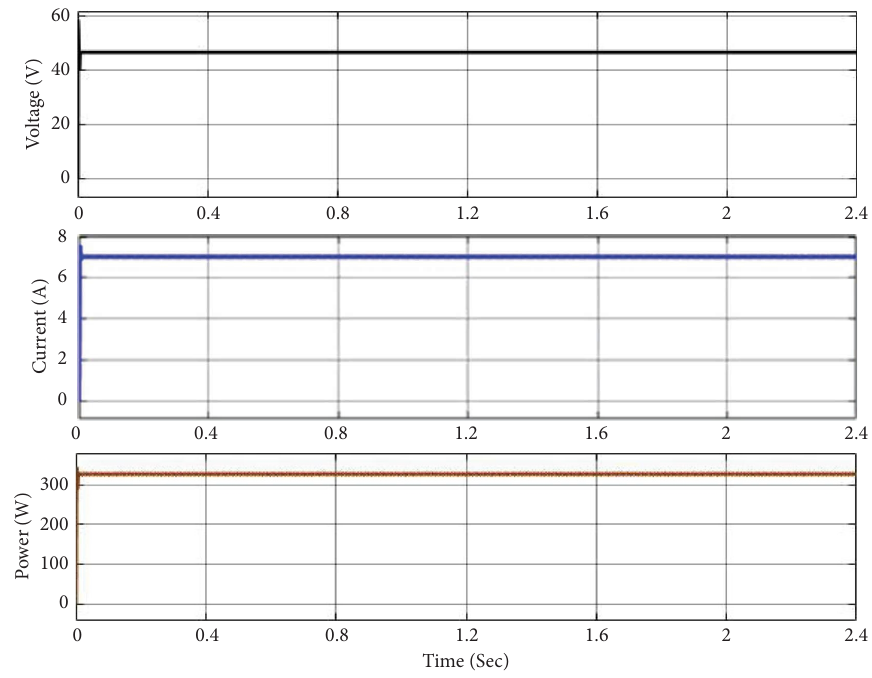
Figure 13: Input voltage, current, and power at converter-1.